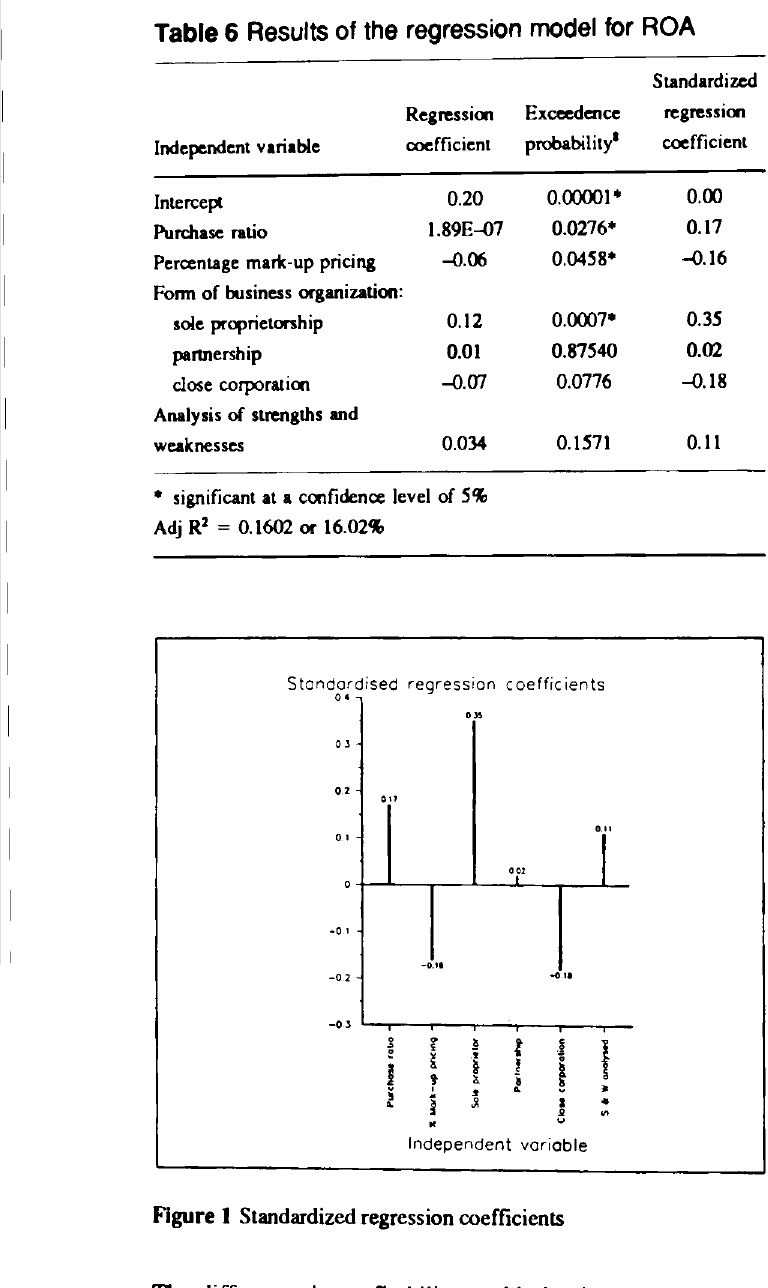
Figure 1 Standardized regression coefficients